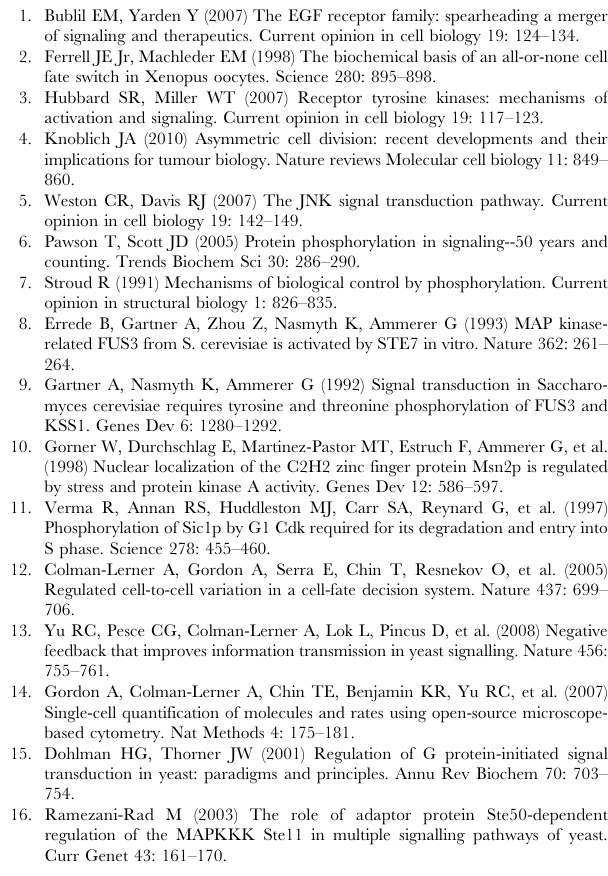
Table S2 Primers used for strain construction and mutagenesis. Table S3 Plasmids used in this study. Table S4 Public database links to phosphopeptides analyzed in this study. Table S5 P-values for mutant